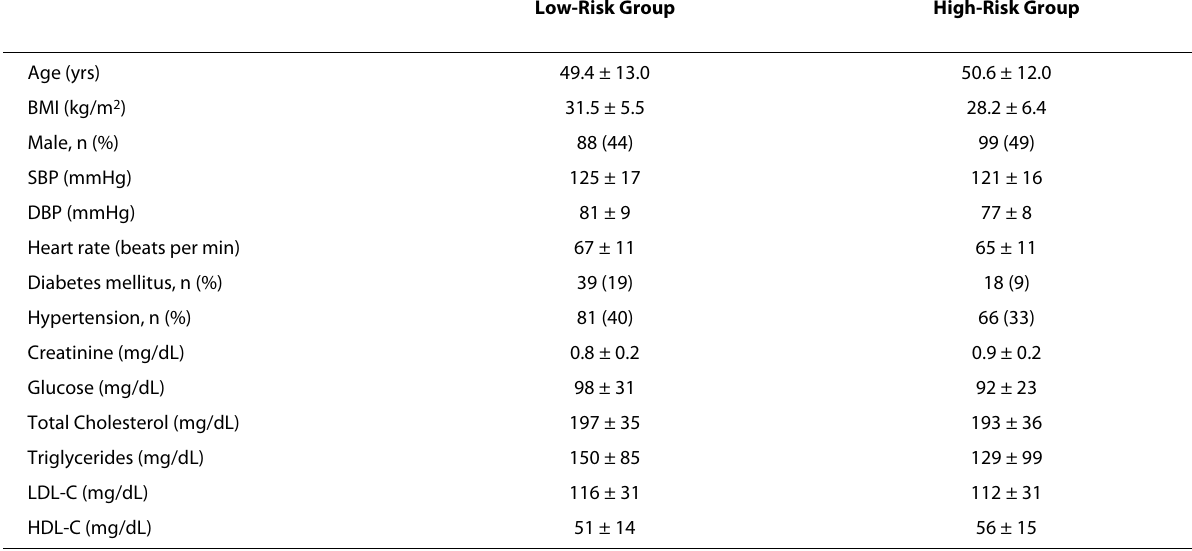
Table 3: Clinical characteristics of the high-risk (n = 201) and low-risk groups (n = 202) using